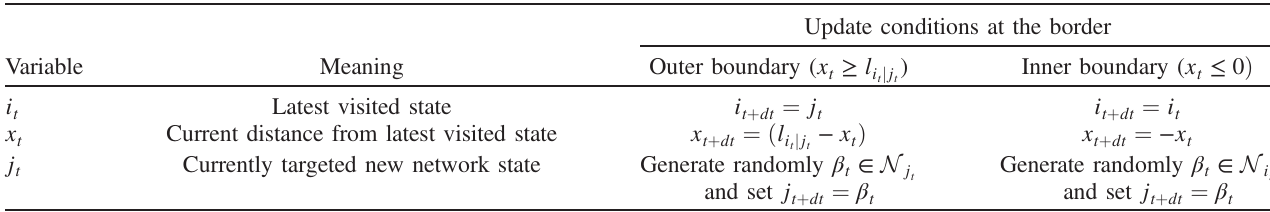
is randomly t k ≤ 0 Þ t